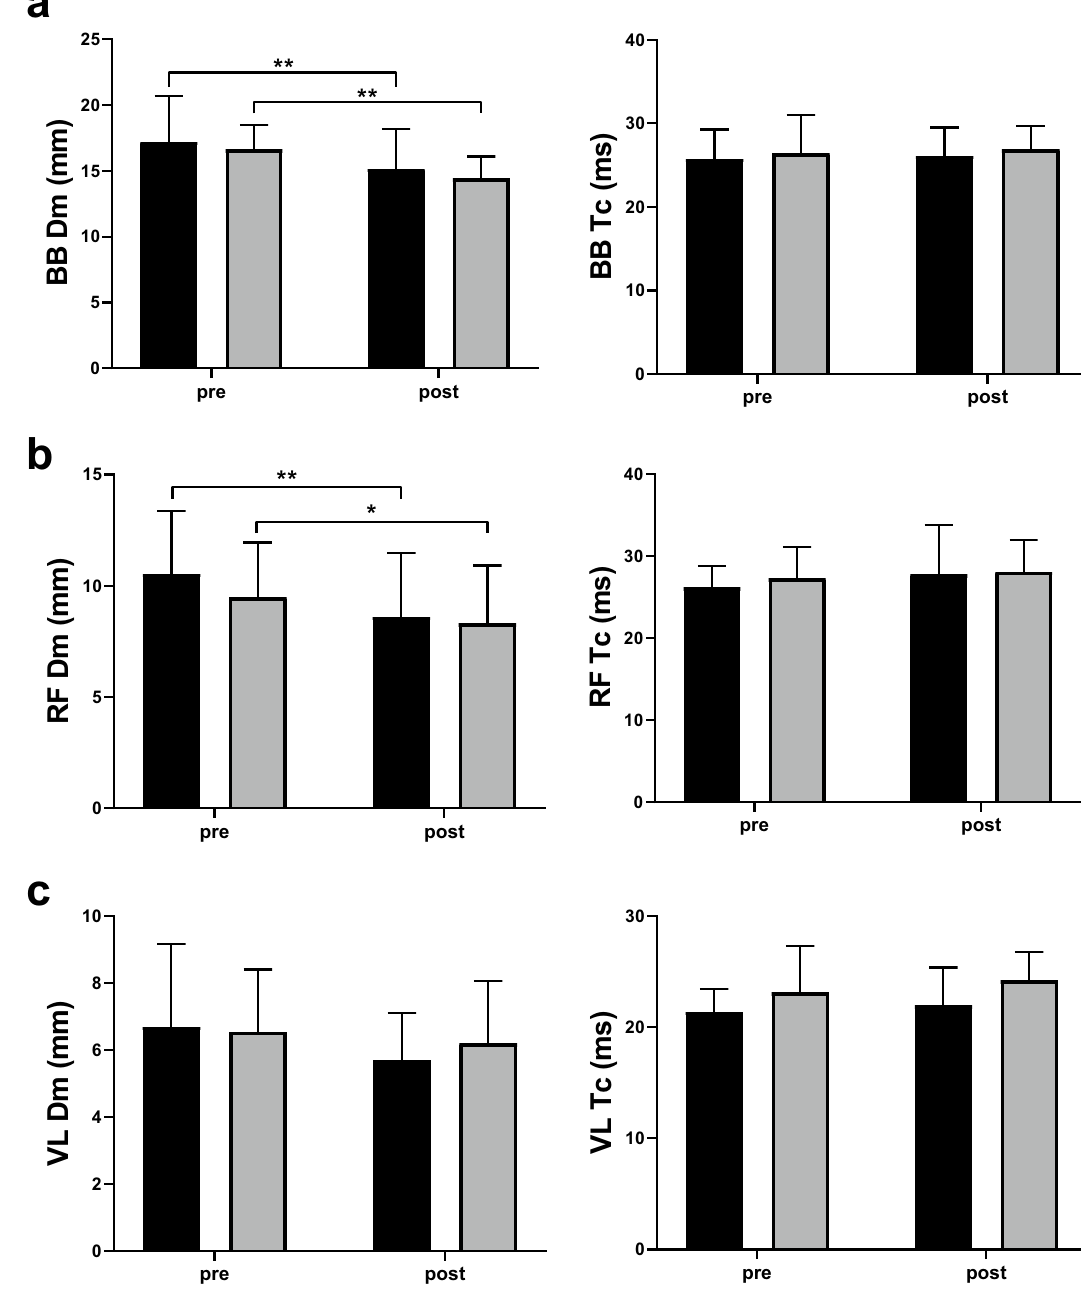
Figure 3. Pre-to-post changes in TMG parameters radial displacement—Dm (left) and contraction time—Tc (right) of biceps brachii ( a ), rectus femoris ( b ) and vastus lateralis ( c ) for males (black fill) and females (grey fill). Graphical representations were generated using GraphPad Prism software version 9.0.2 (https:// www. graph pad. com/ scien tific- softw are/ prism/). *Significantly greater than pre-training (p < 0.05). **Significantly greater than pre-training (p <